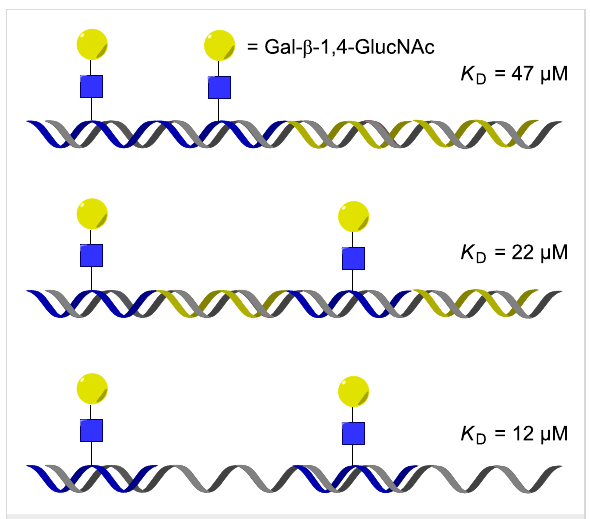
Figure 5: DNA display of ligand bridging opposing binding sites in a lectin (ECL).